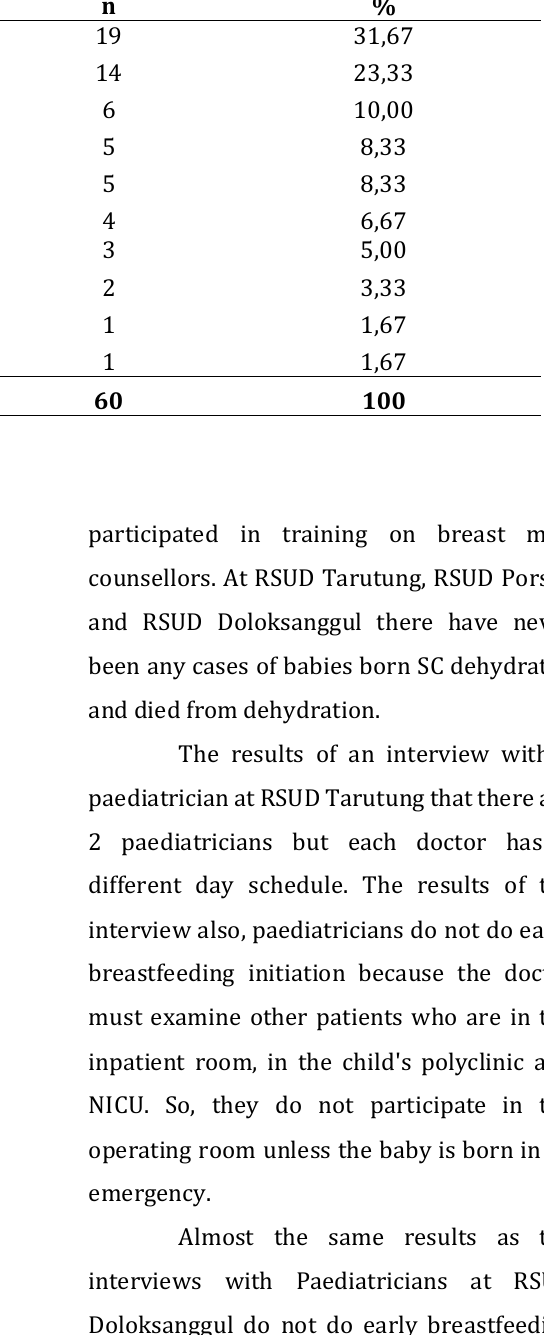
Table 5 Characteristic respondent that consisted of SC Causative Factors of Post Sectio Caesarea mothers SC caused